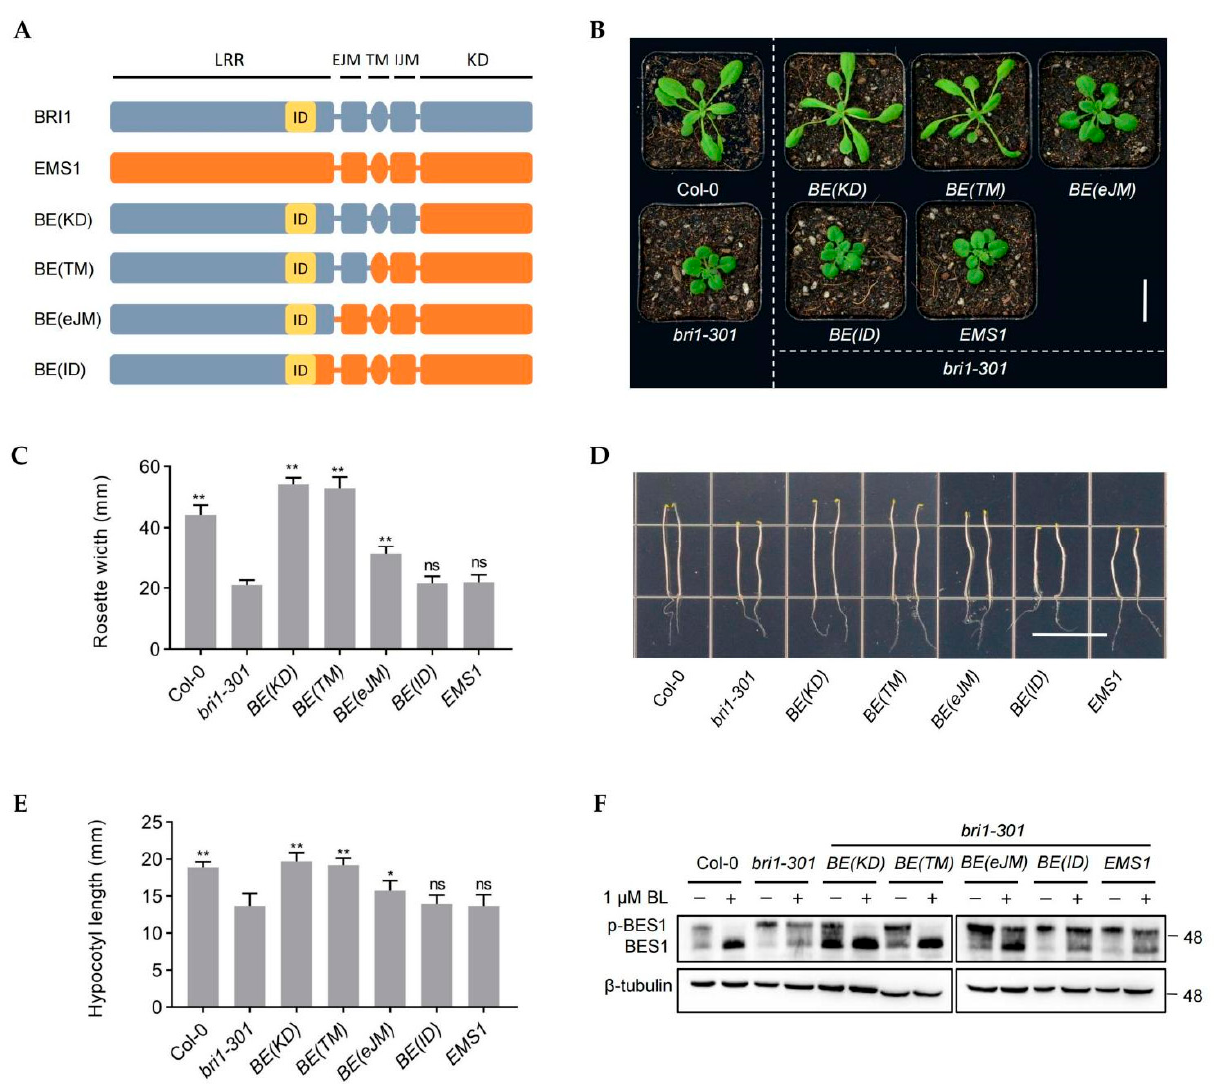
Figure 1. BE(KD), BE(TM) and BE(eJM) could activate BR sigaling. ( A ) Schematic diagram of the extracellular domain of BRI1 fused with different domains of EMS1. The BRI1 and EMS1 protein structures were labeled in gray and orange, respectively. The ID domain is marker in yellow. LRR, leucine-rich repeat; ID, island domain; EJM, extracellular juxtamembrane domain; TM, transmem- brane domain; IJM, intracellular juxtamembrane domain; KD, kinase domain. ( B ) Phenotypes of 4-week-old transgenic lines expressing BE(KD) , BE(TM) , BE(eJM) , BE(ID) , and EMS1 under the BRI1 promoter in bri1-301 background. Scale bar, 2.0 cm. ( C ) Quantification of the transgenic lines with the diameter of the rosette leaves in a whole plant that grew for 4 weeks, n = 10 plants. Statistical analysis was performed to compare the transgenic plants versus bri1-301 , ** p < 0.001 as one-way ANOVA with a Tukey’s test. ( D – E ) The hypocotyl elongation of 7-day-old dark-grown transgenic seedlings in 1/2 MS medium. Scale bar, 1.5 cm. Measurements of hypocotyl length are displayed as means ± SD, n = 10 seedlings. The statistical analysis was performed to compare the transgenic plants’ hypocotyl length versus bri1-301 , * p < 0.05, ** p < 0.001 (one-way ANOVA with a Tukey’s test). ( F ) Dephosphorylation of BES1 in plants. Phosphorylated BES1 (pBES1) and dephosphorylated BES1 were detected with BES1 antibody in the extracts of 10-day-old transgentic seedlings. β -tubulin served as the loading control. BL, brassinolide.